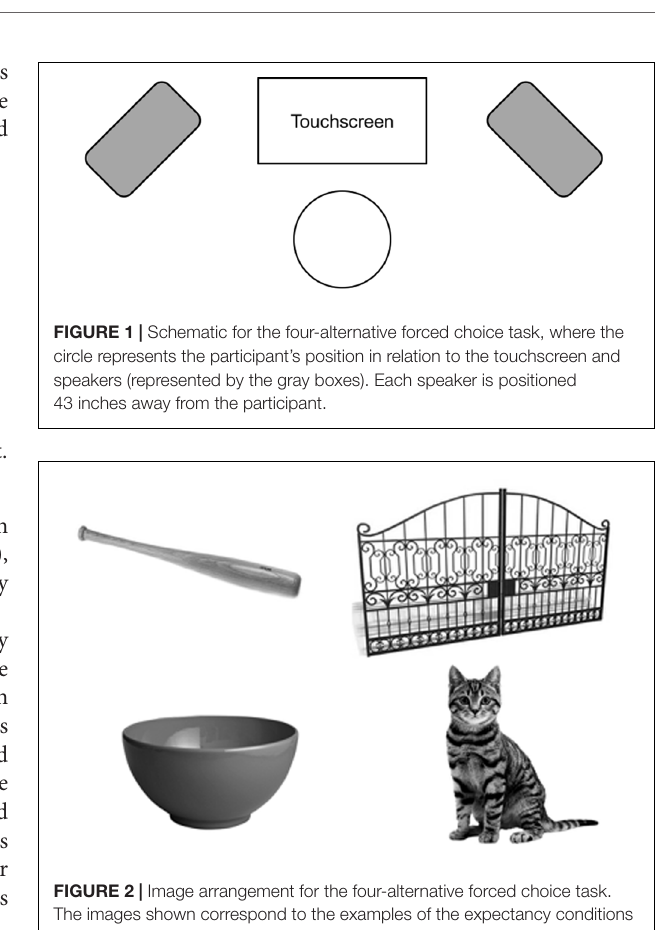
FIGURE 2 | Image arrangement for the four-alternative forced choice task. The images shown correspond to the examples of the expectancy conditions presented earlier. Starting at the top left and proceeding clockwise: the congruent expectancy target (bat), random image (gate), the conflicting expectancy target (cat), and a competitor with the same initial sound as the correct target